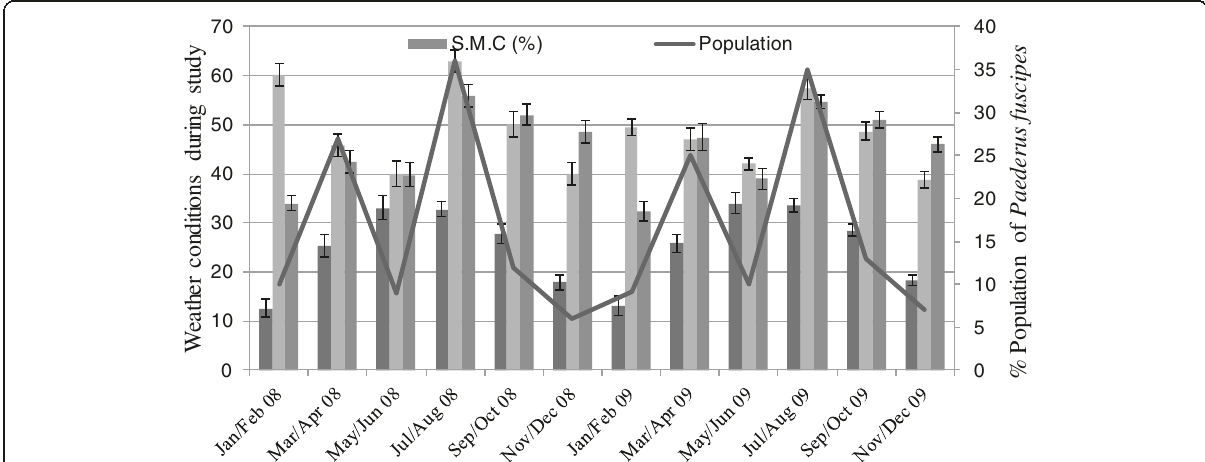
Figure 2 The relationship between abiotic factors during different seasons from 2008 to 2009 and the population of Paederus